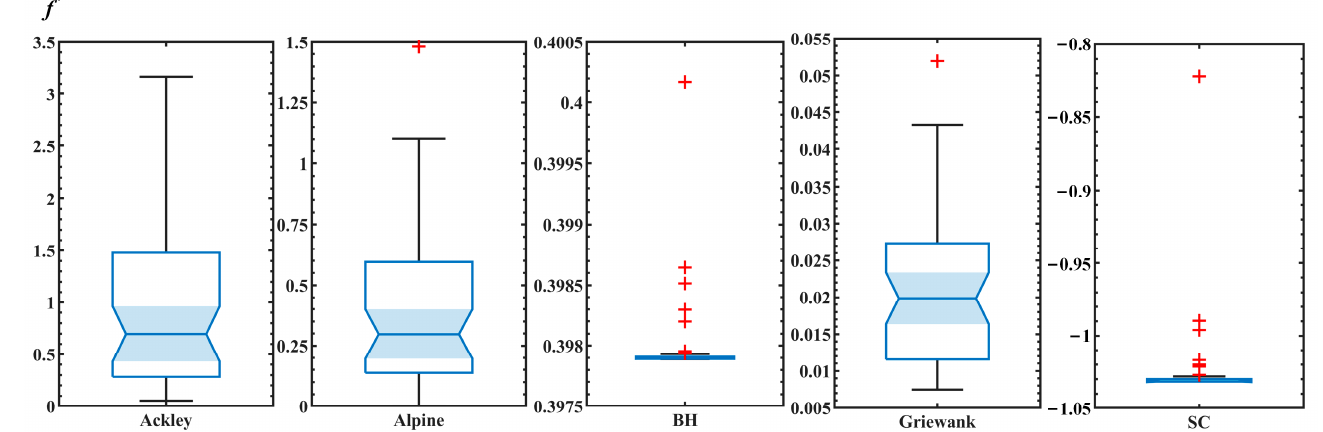
Figure 8. Results of the approximate global minima for each 2 D problem.